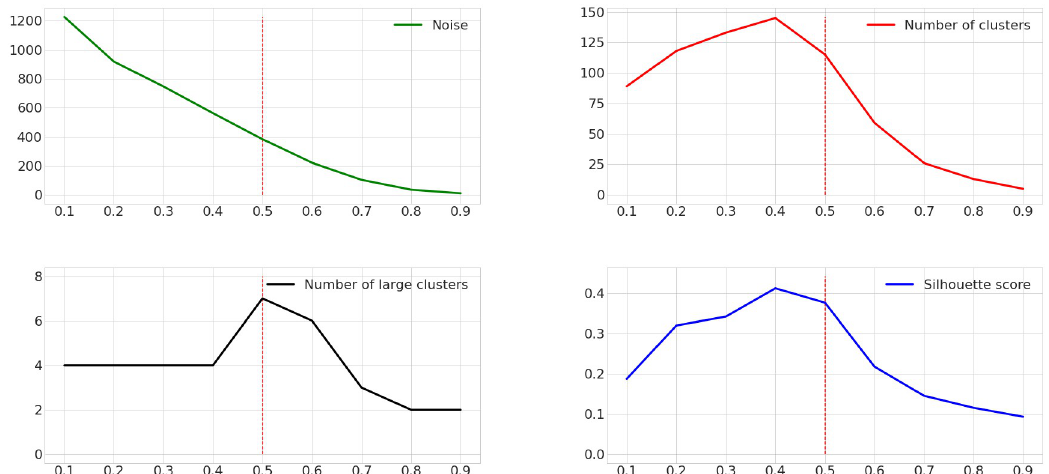
Fig 6. Evolution of the noise (green line), the number of clusters (red line), the number of large clusters (black line) and the mean coefficient silhouette (blue line) with respect to ε and MinPts = 3.